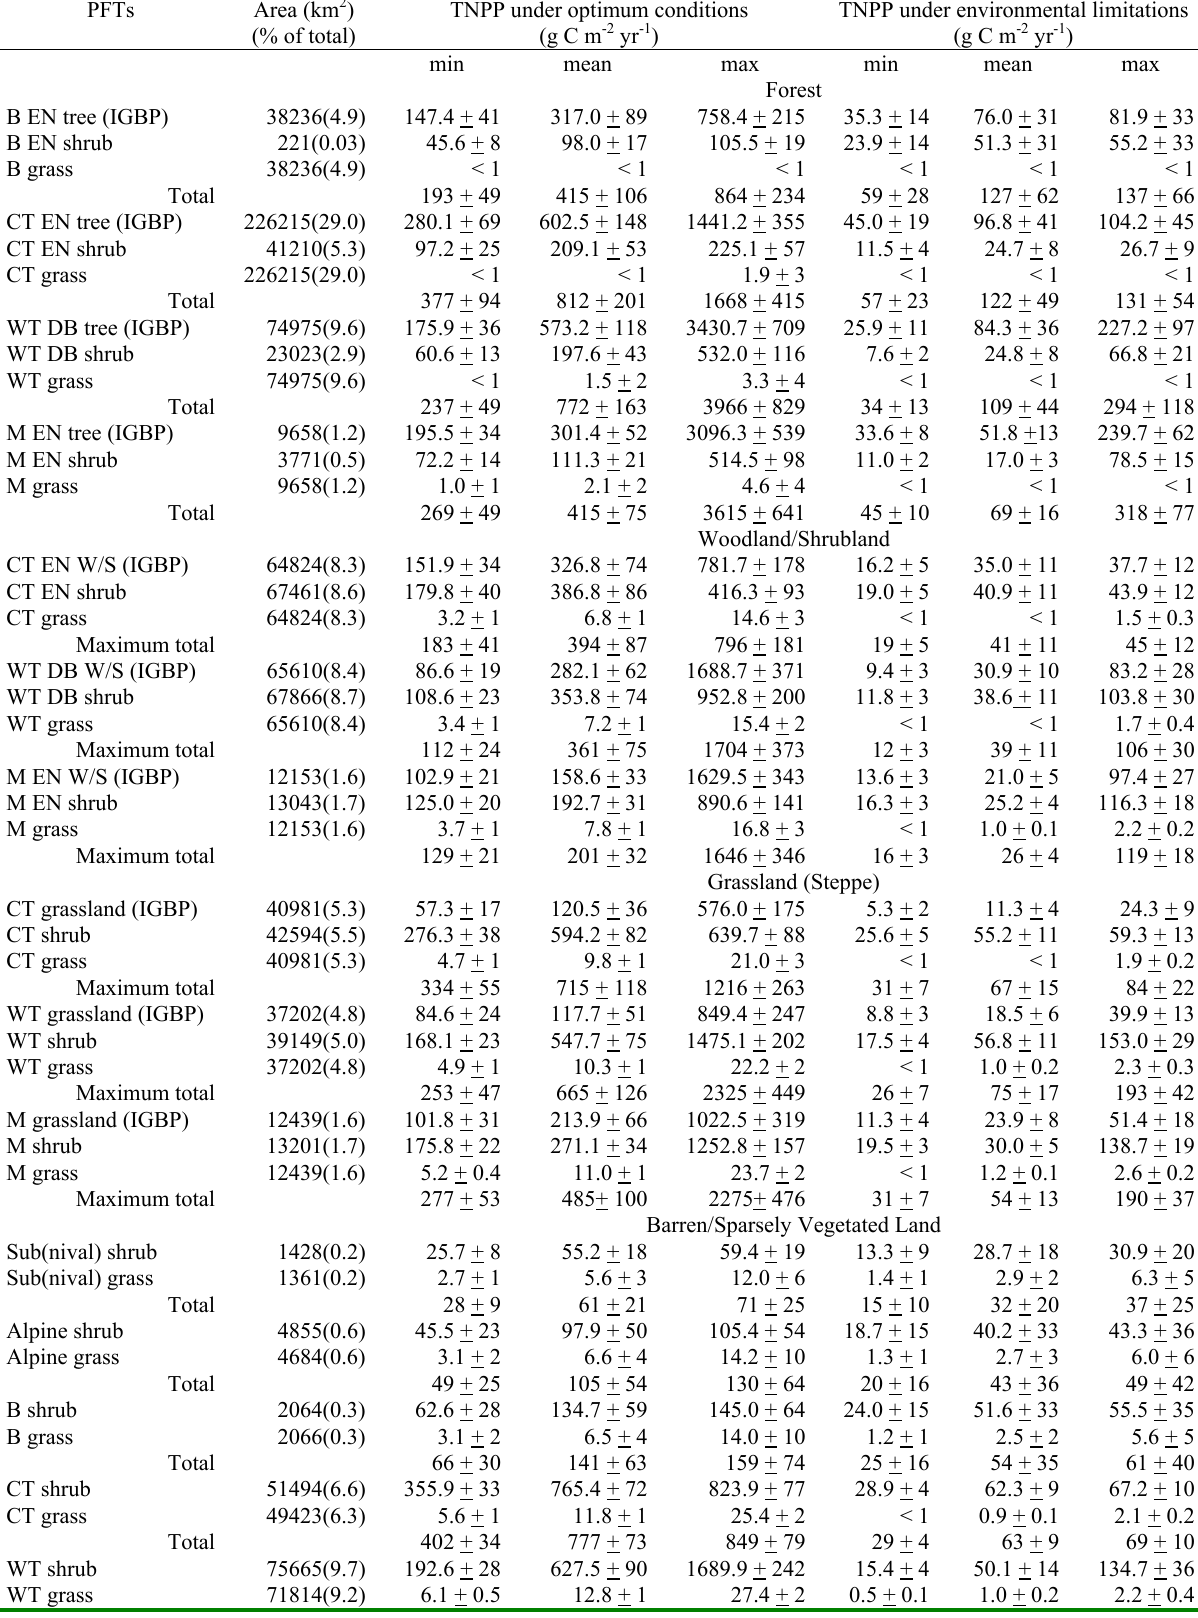
Table 4. Total net primary production (TNPP, g C m -2 yr -1 ) of mutually exclusive and inclusive plant functional types (PFTs) under optimal and growth-limiting conditions as determined by the DECP algorithm according to the IGBP land-cover classification